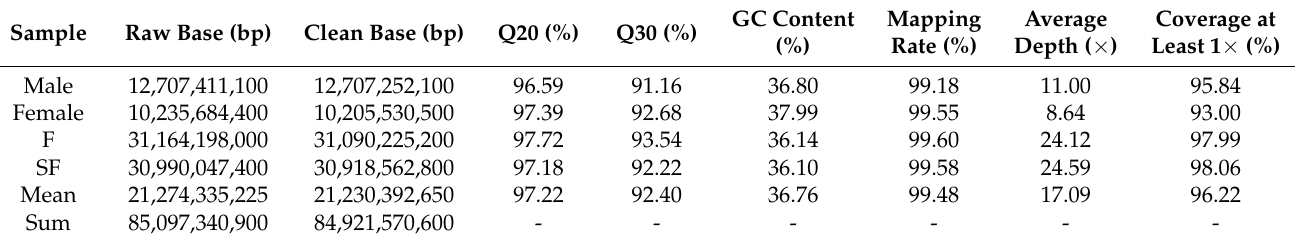
Table 1. Quality appraisal of filtered reads in four samples.